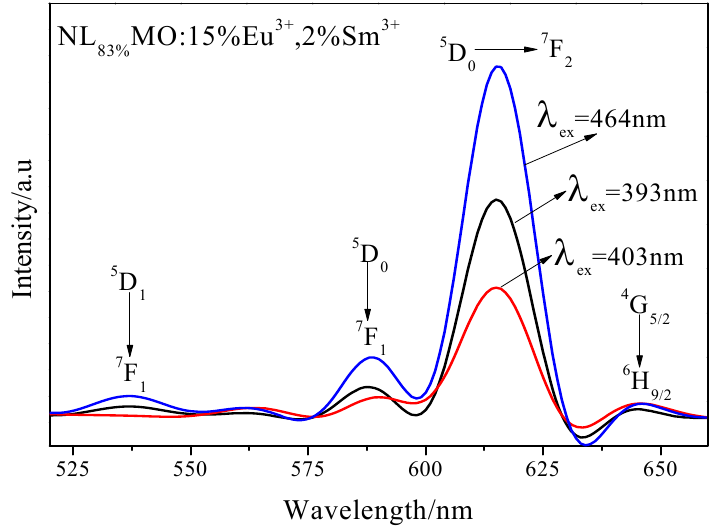
Figure 6. PL spectra of NL 83% MO:15%Eu 3+ ,2%Sm 3+ under the excitation at 393,403 and 465 nm.